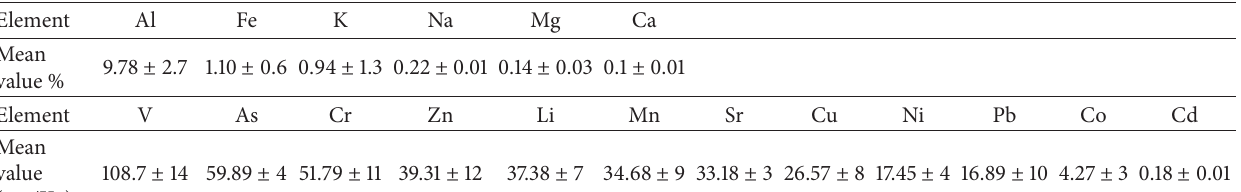
Table 4: The mean values of metallic elements in Bera Lake